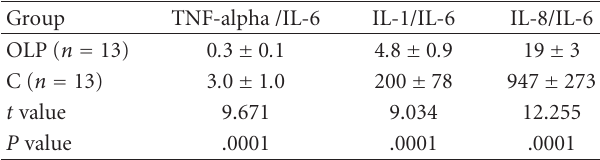
Table 3: Th1/Th2 cytokine ratio in